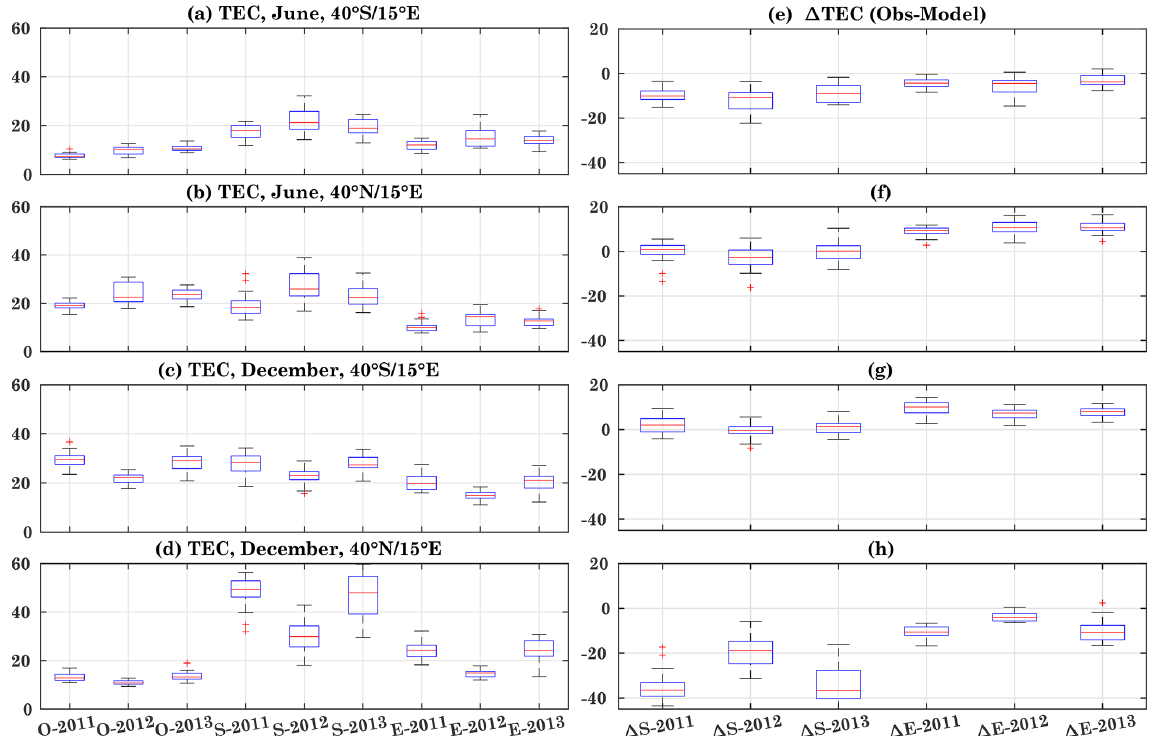
Figure 8. Box plots based on daily TEC during June and December 2011–2013 for 40 ◦ S and 40 ◦ N. The months and location are mentioned in the figure titles. Here O, S, and E represent observed, CTIPe-SOLAR2000 flux model, and CTIPe-EUVAC flux model TEC, respectively. The left panels show the box plots for the difference between observed TEC with the model-simulated TEC using different flux models. Data points beyond the whiskers are displayed using the “ + ” sign.